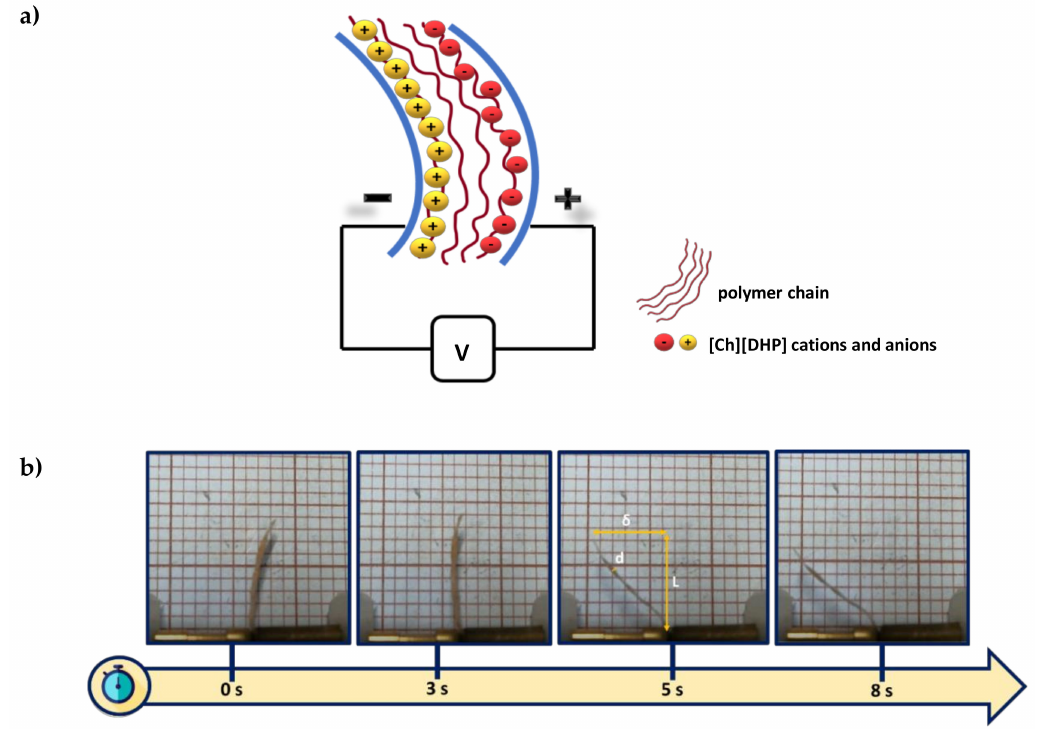
Figure 8. ( a ) Schematic representation of the cation and anion migration and ( b ) bending response as a function of time for NaCMC / [Ch][DHP] composite at a 100 mHz frequency and 8